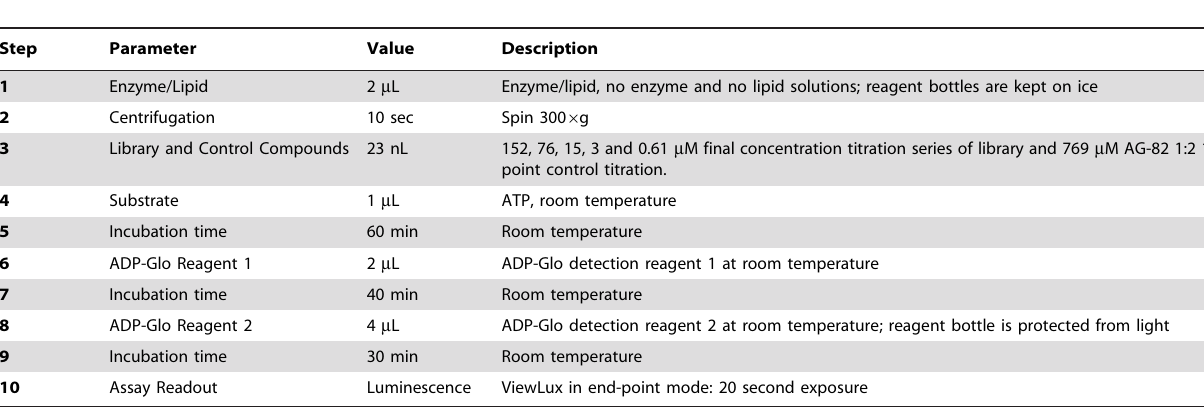
Table 1. Steps of the High-Throughput PI5P4K a